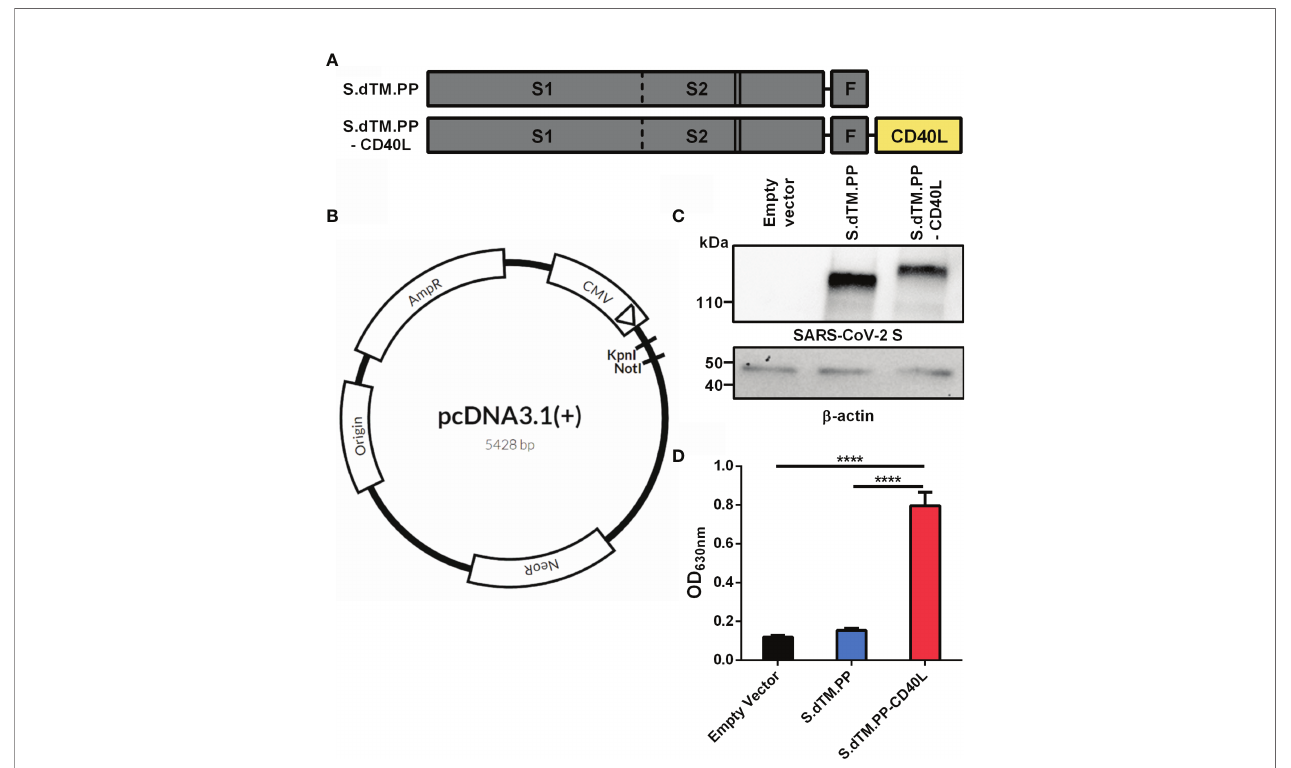
FIGURE 1 | Spike-CD40L fusion antigen design and vaccine characterization. (A) The DNA vaccine antigens were based on a truncated SARS-CoV-2 spike protein lacking the transmembrane domain and C-terminal tail. The S protein was prefusion stabilized via the introduction of two stabilizing proline mutations (solid lines) and the replacement of the furin cleavage site (dotted line). The S protein was fused to a T4 fi britin trimerization motif (F) with or without the ectodomain of CD40L. (B) Antigens were subcloned into pcDNA3.1 (+) vector using KpnI and NotI restriction sites. (C) Antigen expression was detected in BHK-21 cells transfected with the DNA vaccines. Empty pcDNA3.1 was used as a negative control and b -actin expression was used as a loading control. kDa, kilodalton. (D) CD40L reporter HEK293 cells were stimulated for 24h with media collected from HEK293T cells transfected with the DNA vaccines. SEAP expression in the cell culture supernatant post-24h incubation was measured using QUANTI-Blue ™ reagent. Abs 630nm values were measured after a 30-minute incubation. Data shown is mean±SEM; n = 3 per group. ****p <